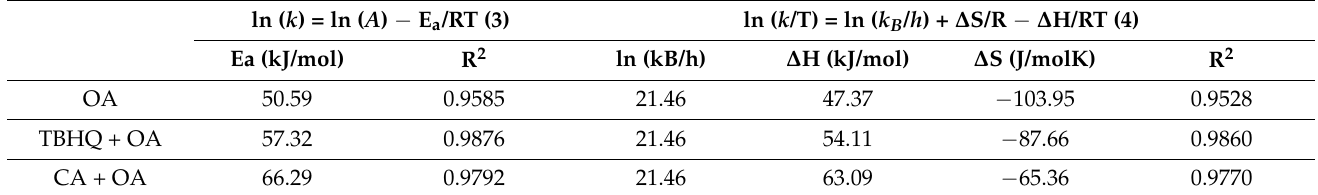
Figure 3. Calibration curves of ln ( 𝑘 ) versus 1/T for OA, TBHQ + OA and CA + OA. Table 3. Arrhenius parameters, ∆ H, and ∆ S of OA, TBHQ + OA and CA + OA. ln ( k ) = ln ( A ) − E a /RT